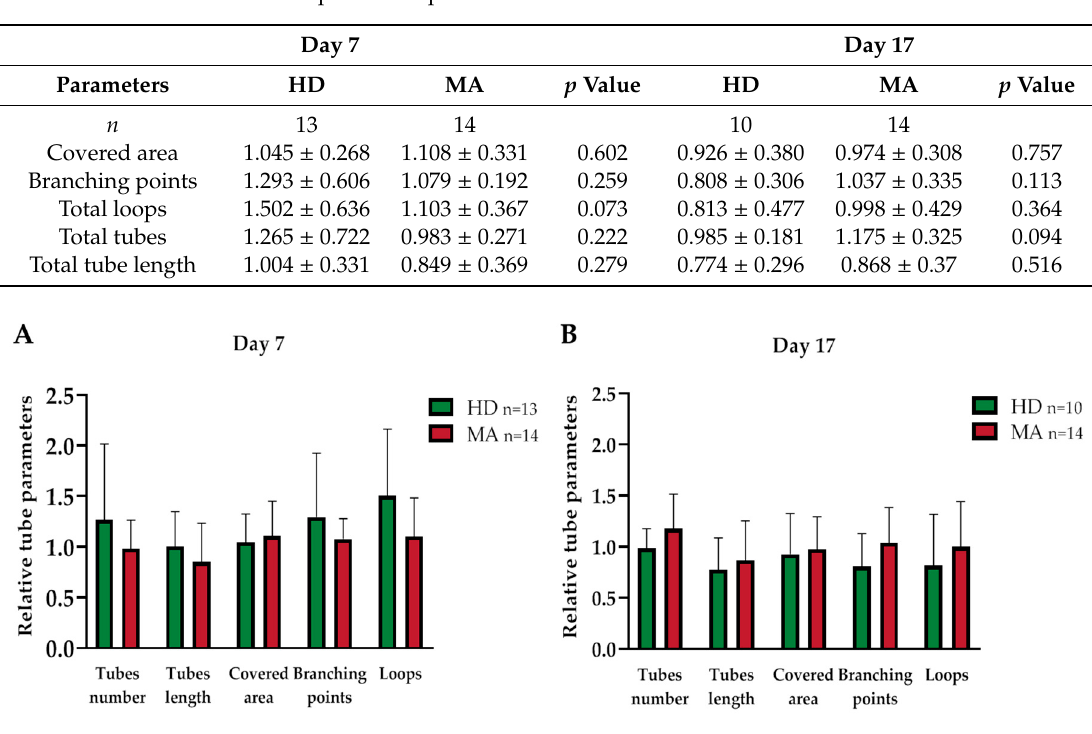
Figure 7. Vasculogenic capacity of HUVEC cells cultured in conditioned media collected ( A ) 7 and ( B ) 17 days after seeding of EPCs from HD and from a homogeneous group of MA patients (each different tube parameter has been normalized with values obtained by HUVEC cells in EGM-MV medium): Data were expressed as mean ± SD, and statistical significance was calculated through Student’s t -test. Values of at least three independent experiments are shown.